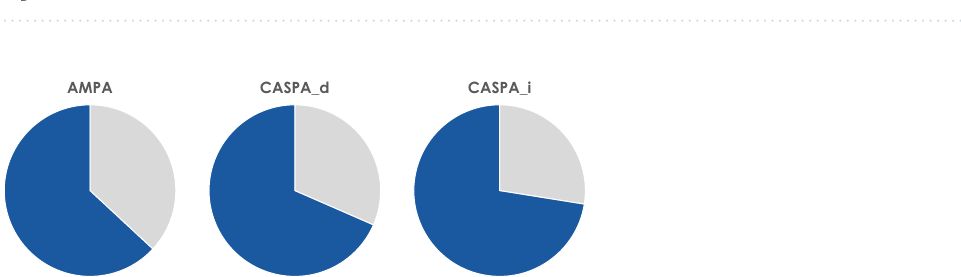
Table 4. Results of SDA-M-based error prediction for Hettich drawer assembly. (a) p < 10 − (c) p =